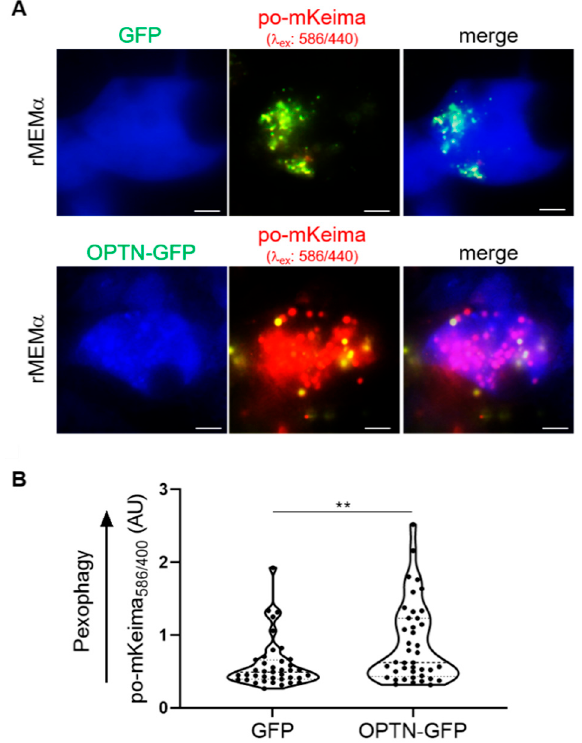
Figure 14. Expression of OPTN-GFP triggers pexophagy. DD-DAO Flp-In T-REx 293 cells expressing po-mKeima were first transfected with a plasmid encoding GFP or OPTN-GFP and subsequently cultured in rMEM α . Two days later, the cells were processed for live-cell imaging. ( A ) Representative fluorescence images of (OPTN-)GFP (false color: blue) and po-mKeima on excitation at 440 (false color: green) and 586 (false color: red) nm. Scale bar, 10 µ m. ( B ) Random fields of view were selected in the bright field, and the 586/440 nm fluorescence excitation ratios of po-mKeima were measured and plotted. **, p <